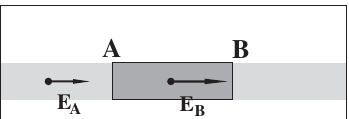
FIG. 4. The electric field at a point outside the resistor is less than the electric field at a point inside the resistor.